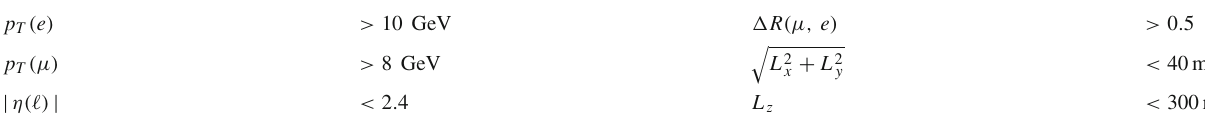
Table 2 Basic cuts for displaced dilepton search